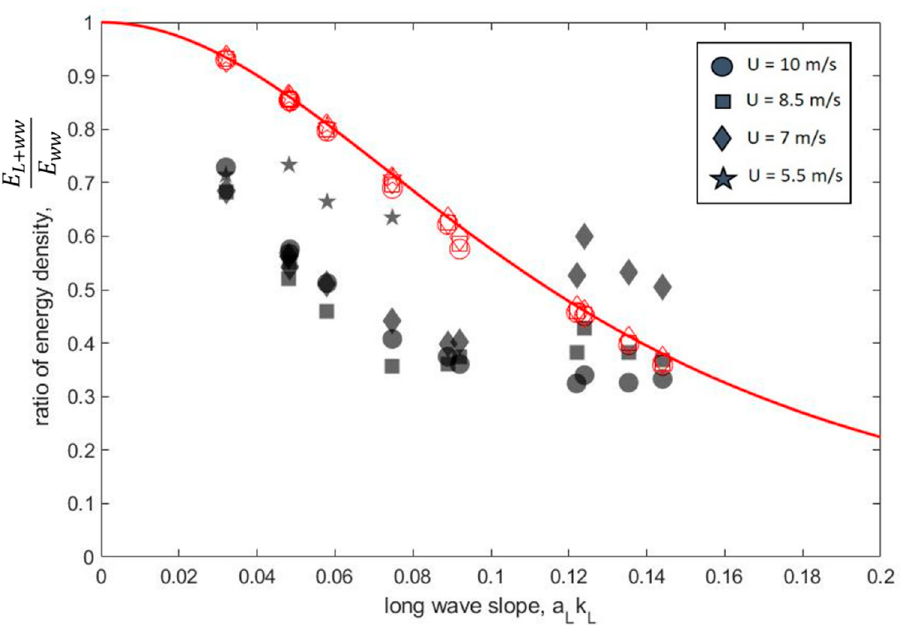
Figure 4. The CBM model results for the experimental irregular wave data. The red, solid line represents the model results for α p = 100, using the simplification of a L k L ~ 0–0.2. Red, open symbols represent model results using Equation (17) to calculate a L k L values of our long waves with no wind. The open symbols correspond to the same wind speeds as the closed symbols. Black, closed symbols represent results from laboratory data.